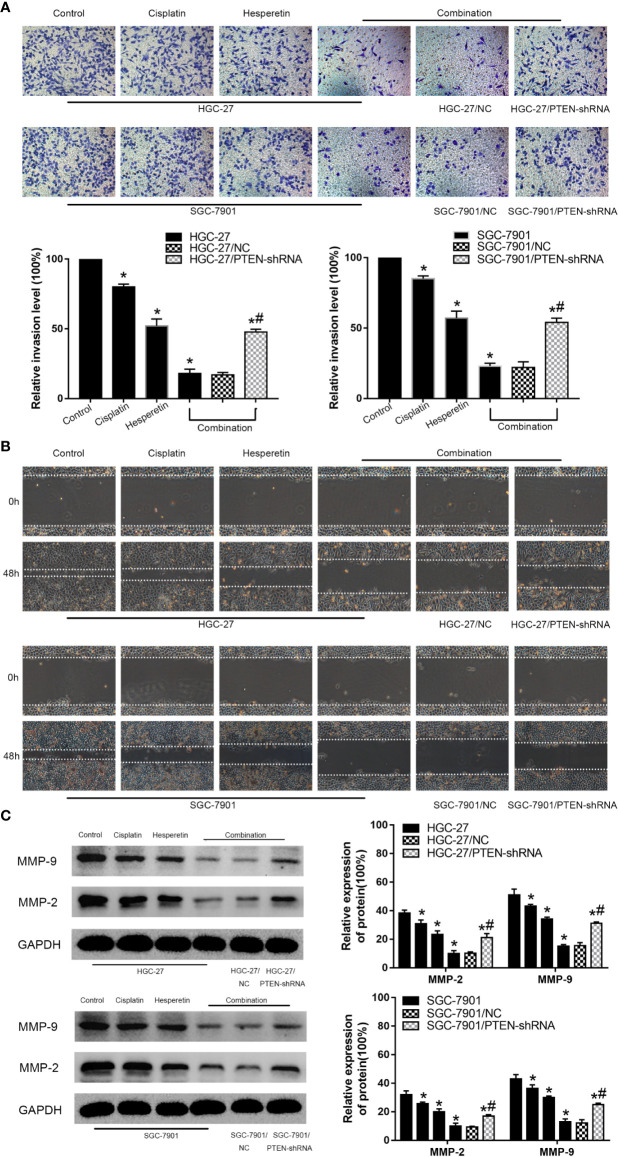
Effects of hesperetin and DDP on the invasion and migration of GC cells using the Transwell invasion assay and the wound-healing assay. (A) Original magnification: 200×. HGC-27 (SGC-7901) cells were treated with control, 4 μg/ml cisplatin, 200 µM hesperetin, or 4 μg/ml cisplatin + 200 µM hesperetin; HGC-27(SGC-7901)/NC and HGC-27(SGC-7901)/PTEN-shRNA were treated with 4 μg/ml cisplatin + 200 µM hesperetin. Quantitative analysis of the average invasive cell numbers in each group. *P < 0.05 vs. the control group, *#P < 0.05 vs. the NC group. (B) Cells were incubated with control, cisplatin, hesperetin, or cisplatin + hesperetin described in (A) above. (C) The levels of MMP-9 and MMP-2 were measured using western blotting and quantitative analysis of the proteins was performed. *P < 0.05 vs. the control group, *#P < 0.05 vs. the NC group. All the above data are the mean ± SD from an average of three experiments.